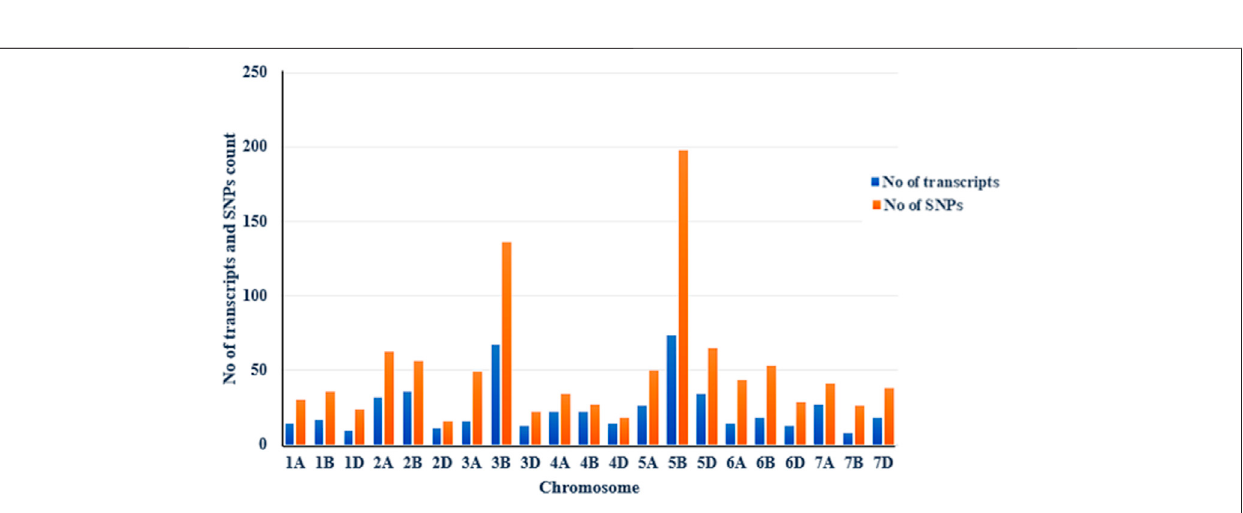
Frontiers in Genetics |